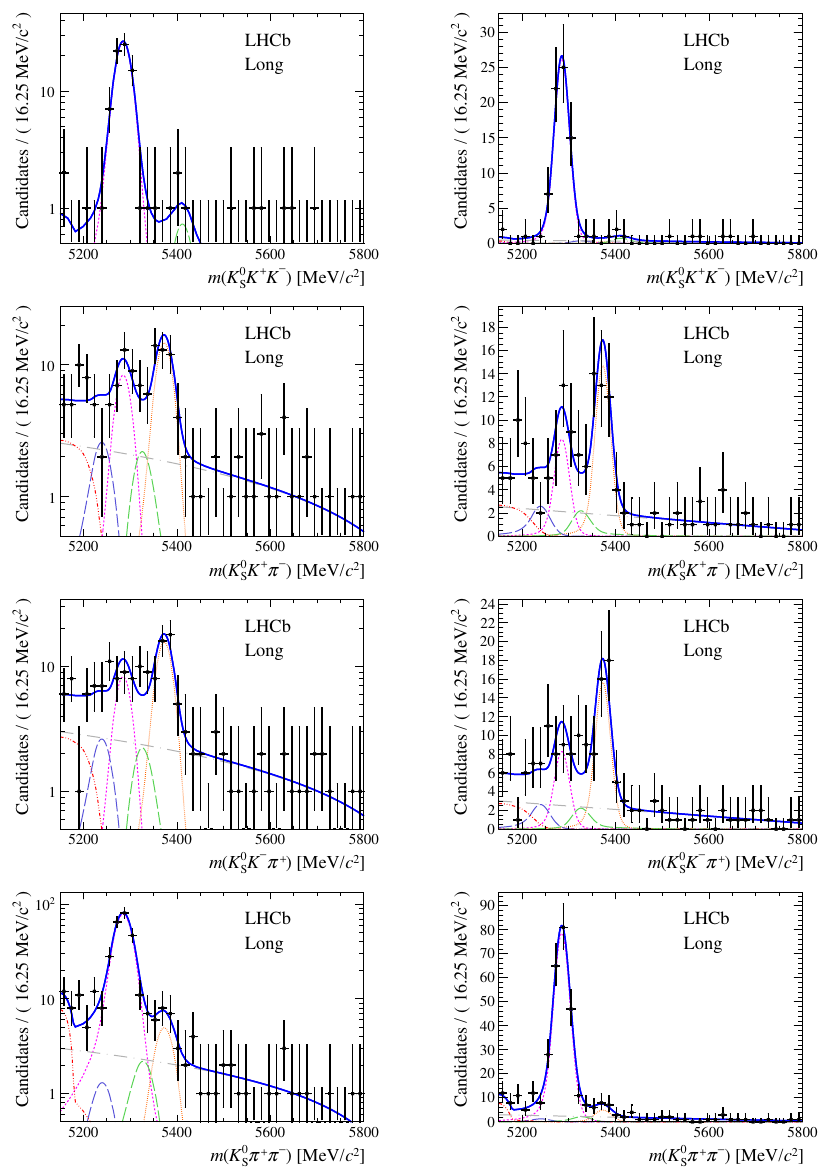
Figure 13 . Results of the simultaneous (cid:12)t to data (long, 2012a) with the BDT optimisation corresponding to the suppressed modes. The modes K 0 are shown from top to bottom. The left-hand side plots show the results with a logarithmic scale and the right-hand side with a linear scale. Legend is similar to that of plots shown in (cid:12)gure 1.